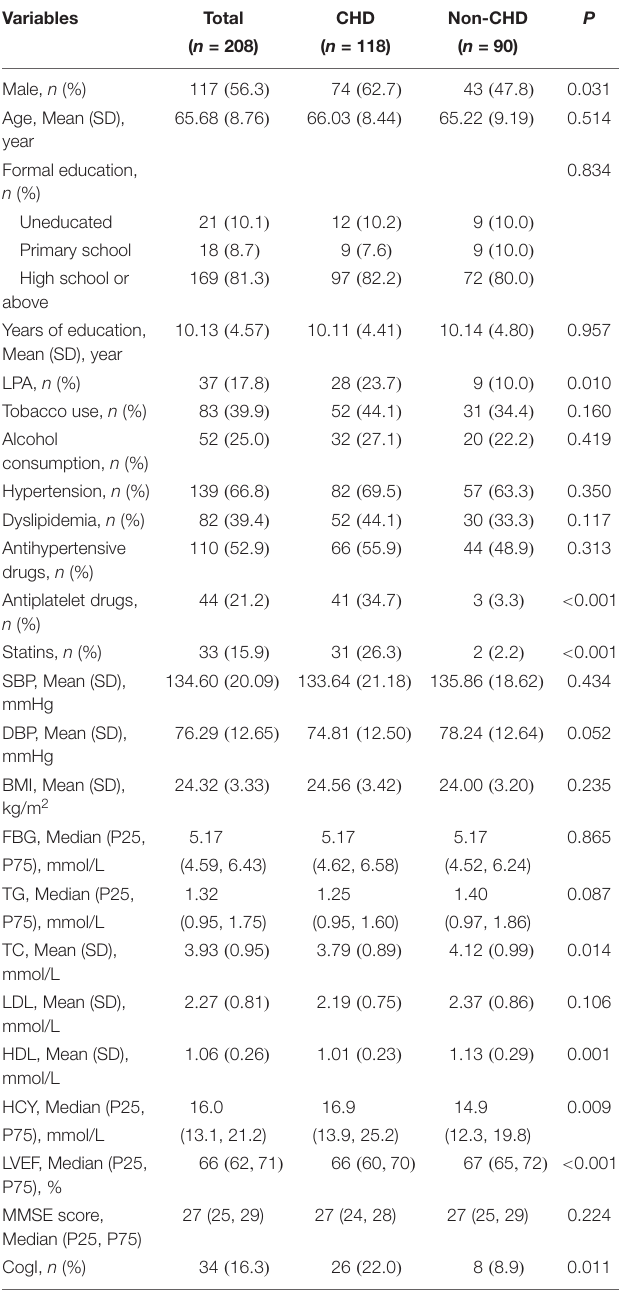
TABLE 1 | Demographic data and clinical characteristics of the study population.